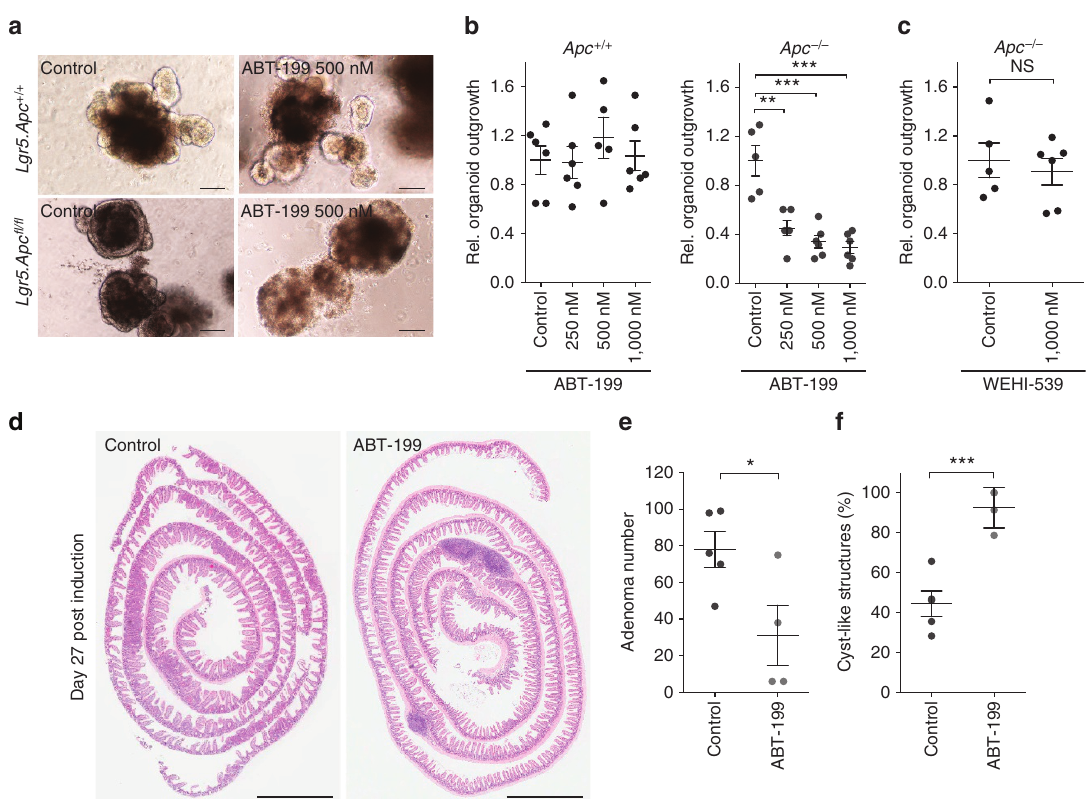
Figure 5 | Pharmacological BCL-2 inhibition reduces tumor initiation. ( a ) Representative bright field images of untreated (left) and BCL-2 inhibitor (ABT-199) treated (right) organoid structures obtained from Lgr5 . Apc þ / þ (top) and Lgr5 . Apc fl/fl (bottom) mice 5 days after induction with tamoxifen. Scale bar, 50 m M. ( b ) Graphs depict the relative outgrowth of structures 7 days after passaging for the indicated genotype and ABT-199 dose at time of induction. Each dot represents a replicate (minimal n ¼ 5 per condition), error bars indicate the s.e.m. ** P o 0.01, *** P o 0.001, Student’s t -test. ( c ) Graph depicting the relative outgrowth of Apc (cid:2) / (cid:2) structures 7 days after passaging treated with BCL-XL inhibitor (WEHI-539, 1,000nM) at time of induction. Each dot represents a replicate (minimal n ¼ 5 per condition), error bars indicate the s.e.m. NS, not significant, Student’s t -test. ( d ) Representative H&E images of sections of the small intestine of Lgr5 . Apc fl/fl mice, which were killed at day 27 post induction. The ABT-199 treated cohort received 100mgkg (cid:2) 1 ABT-199 starting 2 days before induction for three consecutive days followed by administration every other day until day 27. Scale bars, 2mm. ( e ) Graph displaying the number of adenomas at day 27 post induction. Each dot represents a mouse (minimal n ¼ 4 per condition), error bars represent the s.e.m. * P o 0.05, Student’s t -test. ( f ) Plot showing the quantification of the fraction of cyst-like structures in control and ABT-199 treated mice. Each dot represents a mouse (minimal n ¼ 3 per condition), error bars represent the s.e.m. *** P o 0.001, Student’s t